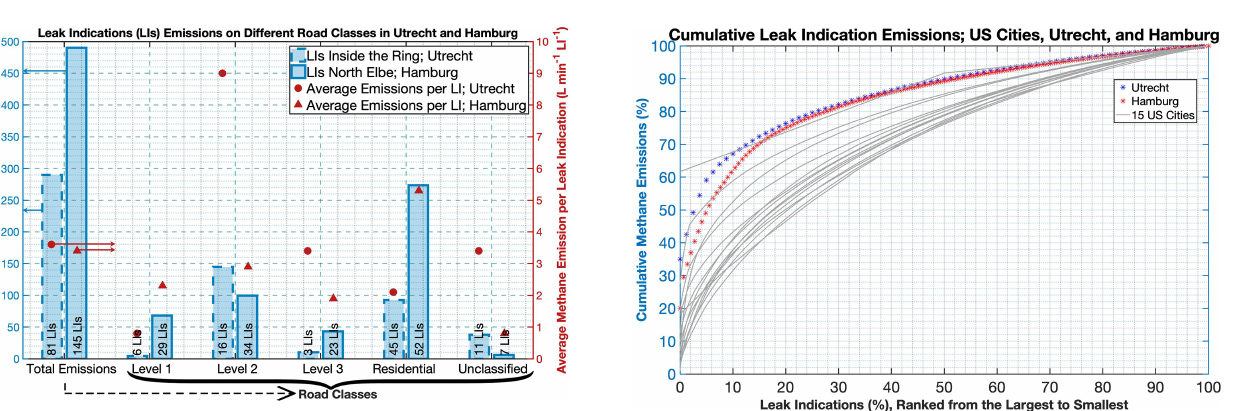
Figure 4. Cumulative plot of CH 4 emissions across US cities, Utrecht, and Hamburg; datasets for the US cities are from Weller et al.